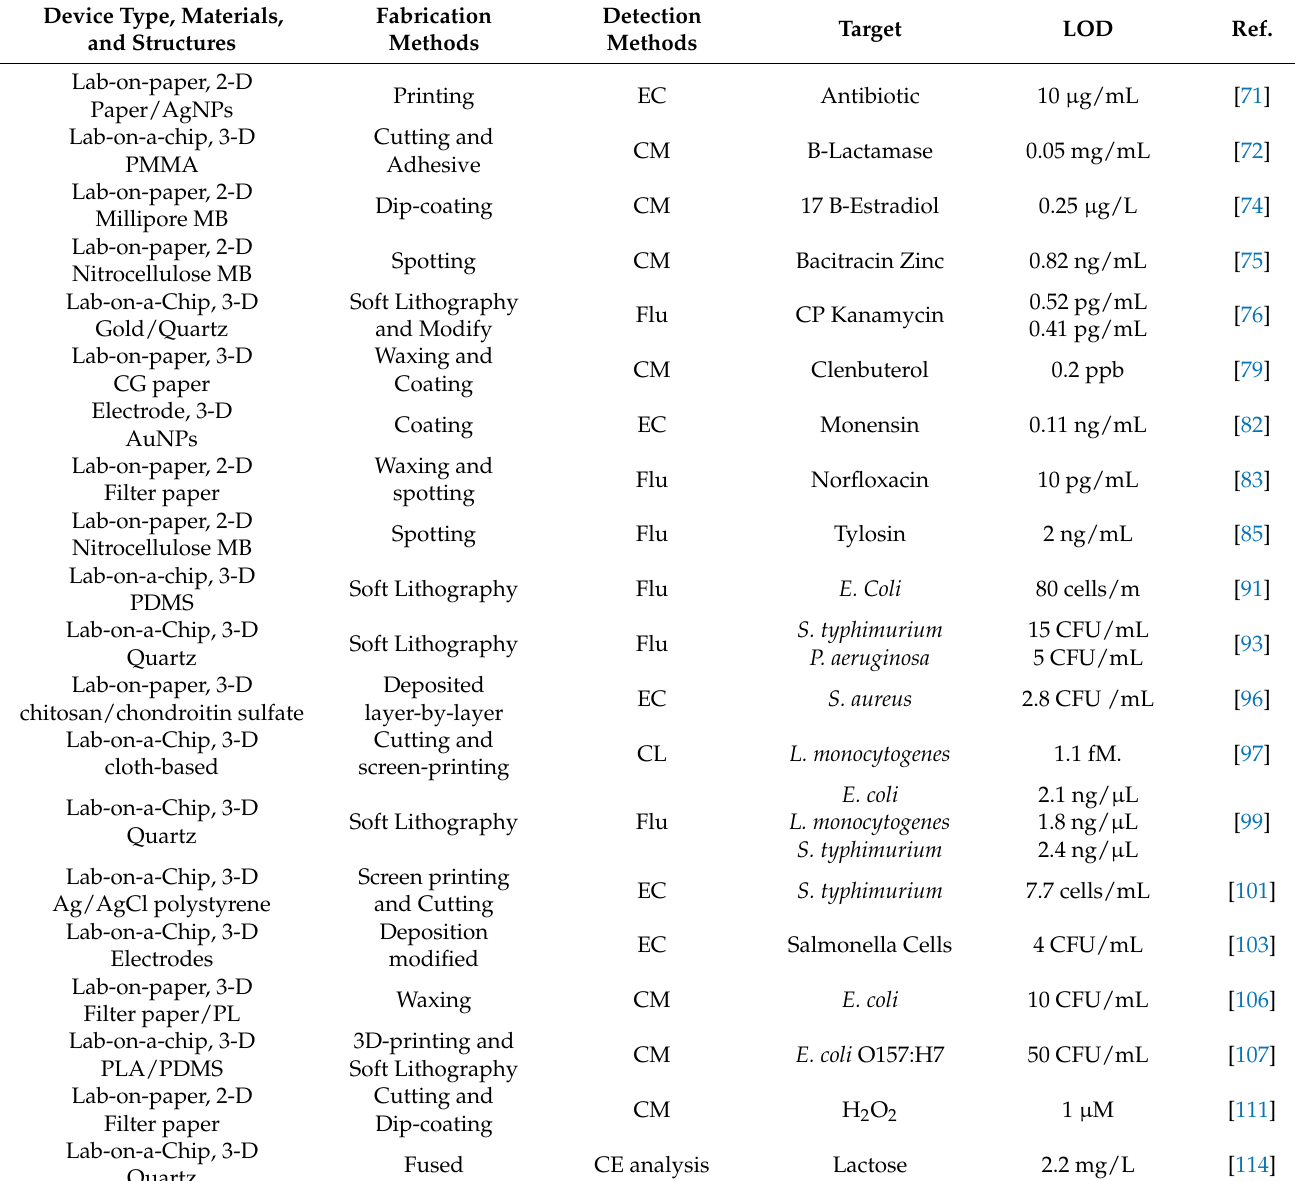
Table 2. Summary of the microfluidic devices used for milk contamination